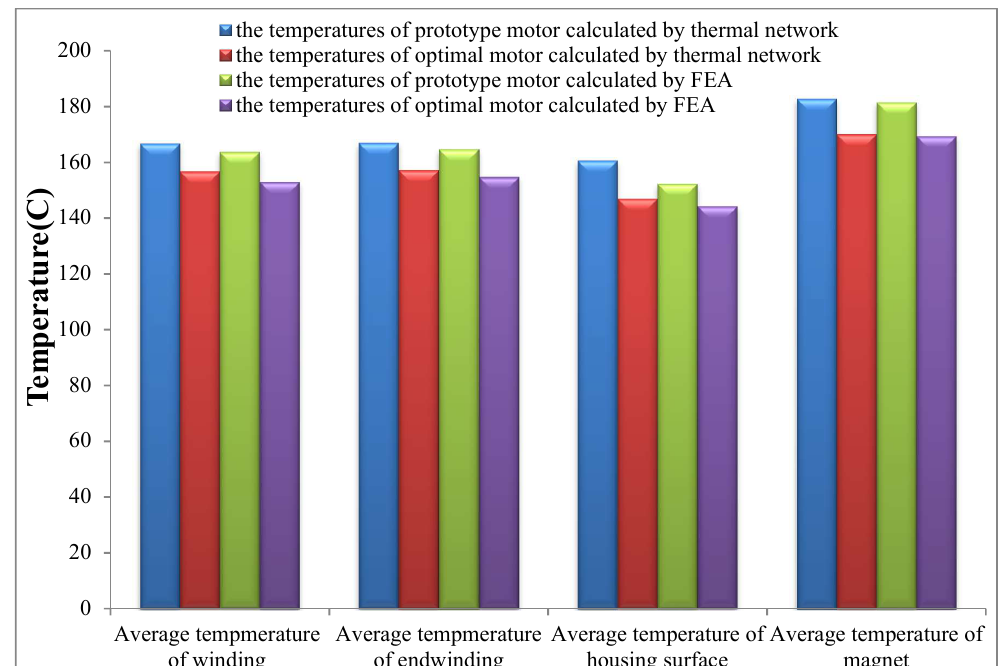
Figure 11. Temperature comparison of prototype machine and optimal machine calculated by FEA and thermal network.